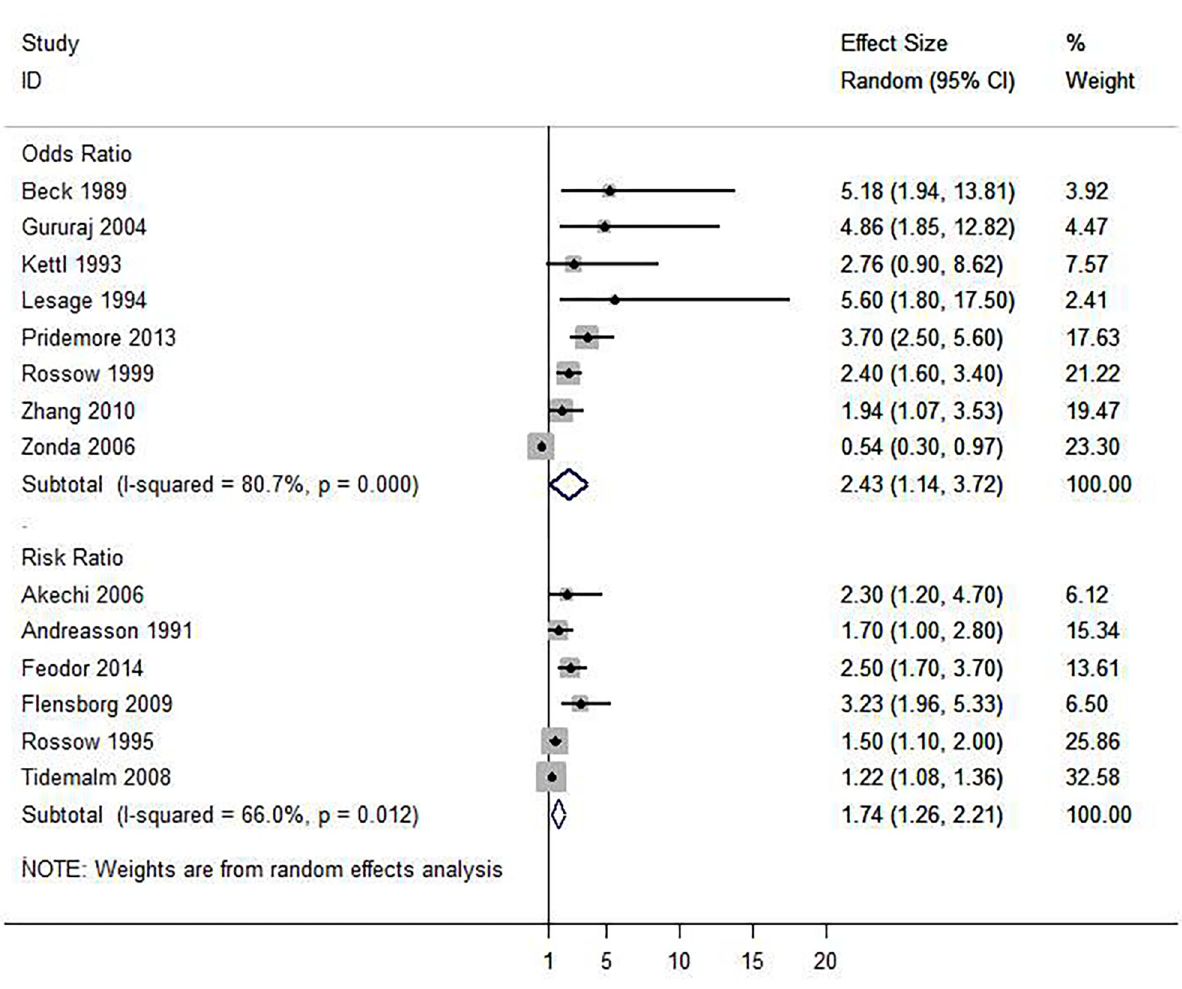
Fig 4. Forest plot of the association between alcohol use disorder and completed